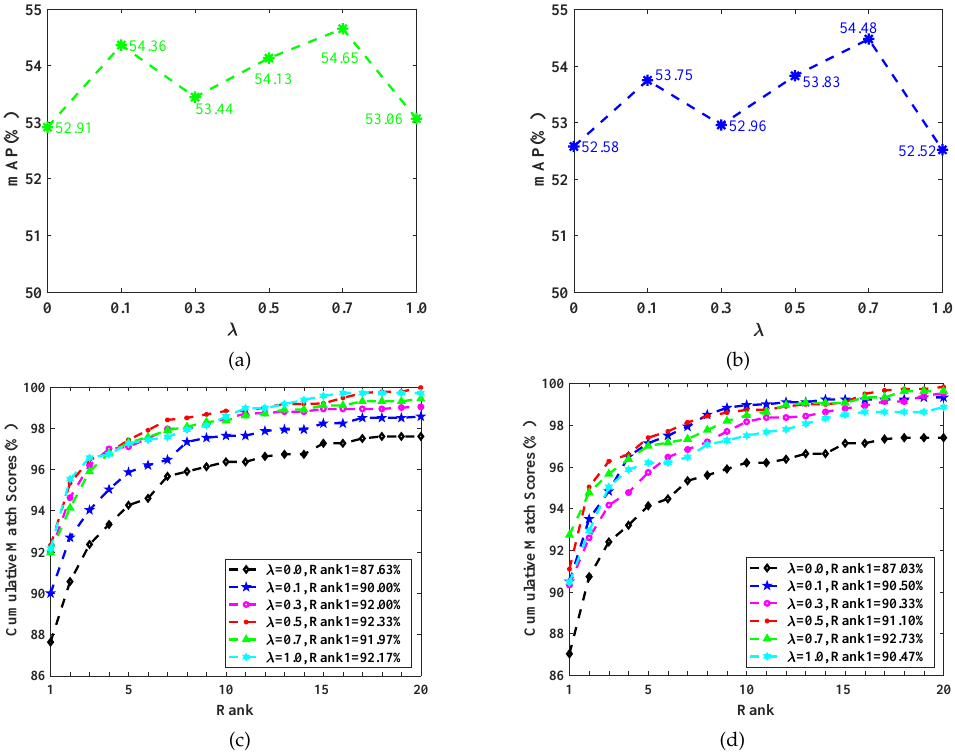
Figure 7. The performance of using different modal discrepancy suppression degrees (i.e., λ in Equation (7)) on the RGBNT201 dataset. ( a ) V2I mAP, ( b ) I2V mAP, ( c ) V2I Rank1, and ( d ) I2V Rank1. Table 3. The performance of using different sized margins on the M 3 D loss (i.e., Equation (3)) on the RGBNT201 dataset. The V2I and I2V denotes the visible-to-infrared and infrared-to visible retrieval